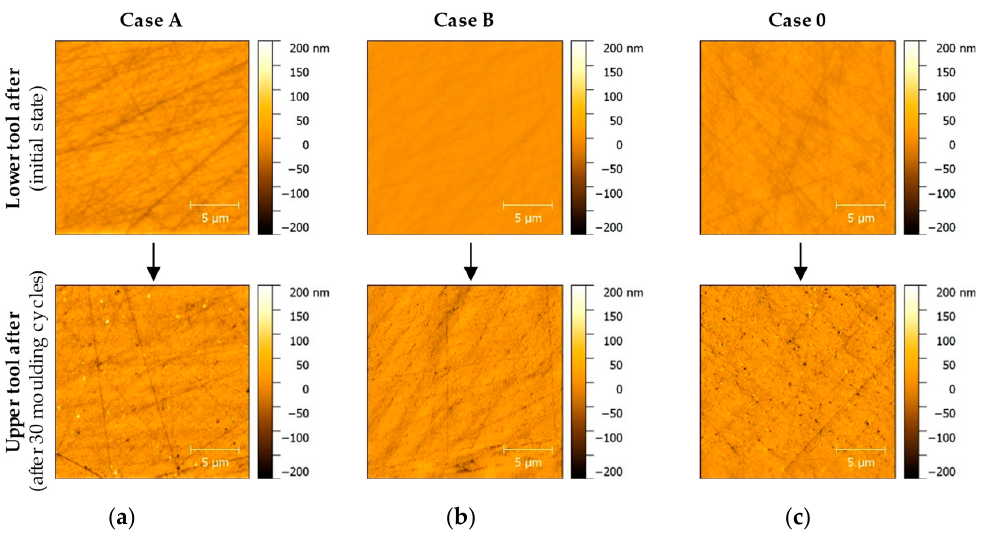
Figure 13. Comparison of the different surface finishing cases: ( a ) Case A; ( b ) Case B; ( c ) Case 0.